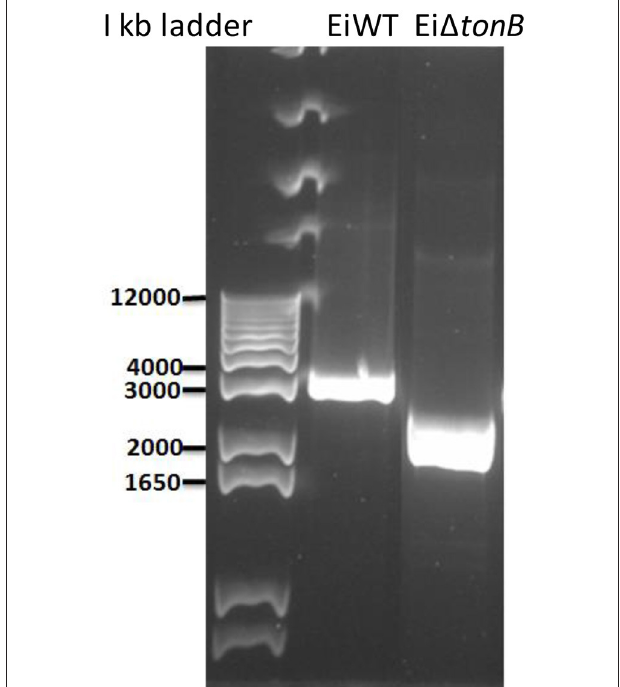
FIGURE 1 | Agarose gel picture showing genotypic confirmation of the Ei 1 tonB strain by PCR. Lane one is KB Ladder. Lane two is PCR product amplified from wild-type E. ictaluri . Lane three is PCR product amplified from genomic DNA of the Ei 1 tonB strain.